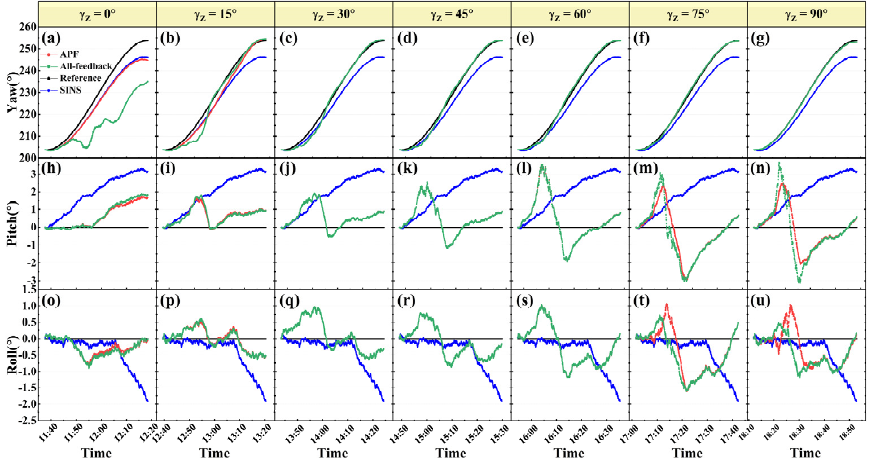
Figure 8. The estimation curves of 3D attitude angles, i.e. yaw ( a – g ), pitch ( h – n ), and roll ( o – u ), for different γ z .